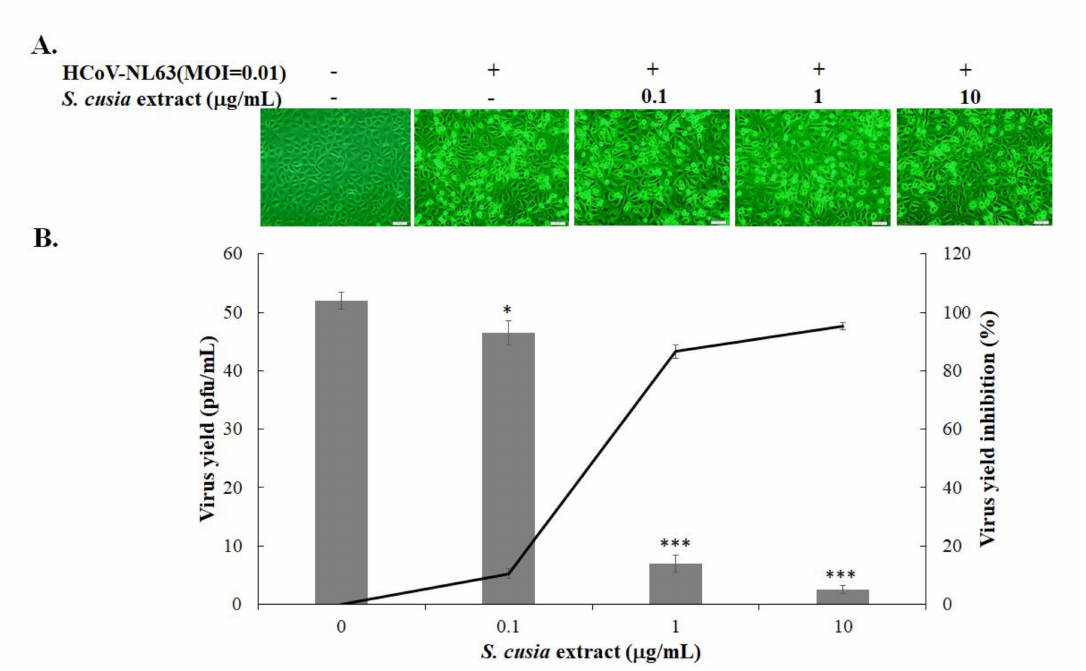
Figure 1. Inhibitory e ff ects of S. cusia leaf methanol extract on viral cytopathicity and progeny virus production in HCoV-NL63-infected cells. LLC-MK-2 cells were infected with HCoV-NL63 at 0.01 multiplicity of infection (MOI) and simultaneously treated with the extract. Virus-induced cytopathic e ff ects were imaged 36 h post-infection (hpi) by microscopy ( A ). The supernatant from treated infected cells was harvested 36 hpi and serially diluted for determining the HCoV-NL63 yield in the supernatant using the plaque assay ( B , right y axis). The rate of virus yield inhibition was calculated based on the ratio of the loss in the titer of the treated group to mock-treated group ( B , left y axis). + , add; − , not add; *, p value < 0.05; ***, p value < 0.001 compared with mock-treated infected cells. Scale bar, 100 µ